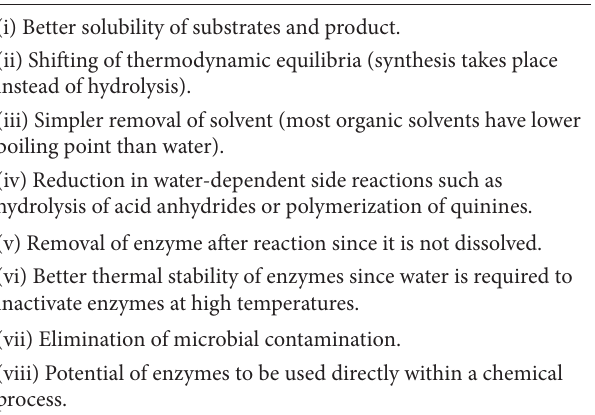
Table 2: Advantages of organic solvents over aqueous